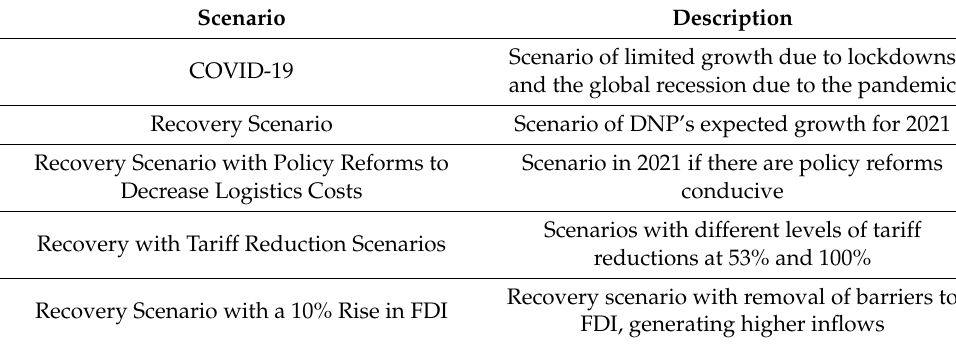
Table 3. Growth Scenarios for the Colombian Economy: